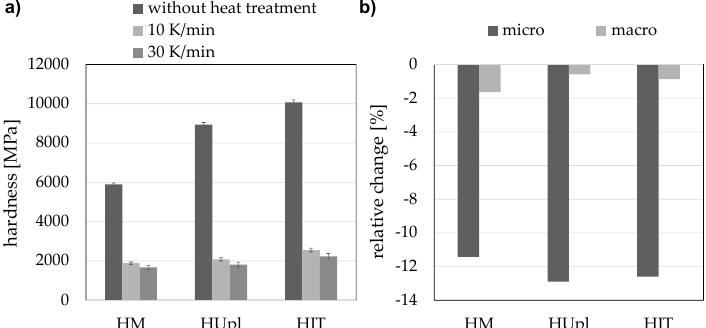
Figure 10. ( a ) Hardness descriptors of micro samples with different heat treatments in the DSC; ( b ) relative change in hardness descriptors when varying the heating rate of DSC from 10 K/min to 30 K/min of micro and macro samples.